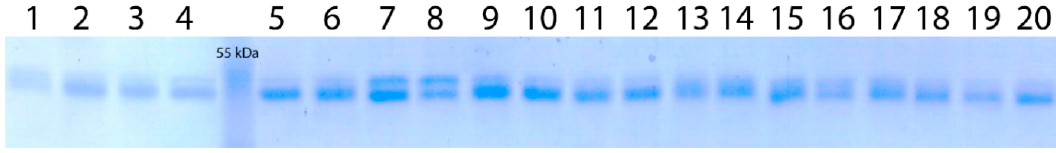
Figure 2. One-dimensional SDS–PAGE patterns of waxy proteins of wheat–wheatgrass hybrids: 1— 50; 2, 3—ZP26/1; 4—1783; 5, 6—4044/4; 7, 8—1416; 9, 10—1779.1; 11, 12—166; 13—1512; 14, 15—1765; 2, 3—ZP26 / 1; 4—1783; 5, 6—4044 / 4; 7, 8—1416; 9, 10—1779.1; 11, 12—166; 13—1512; 14,